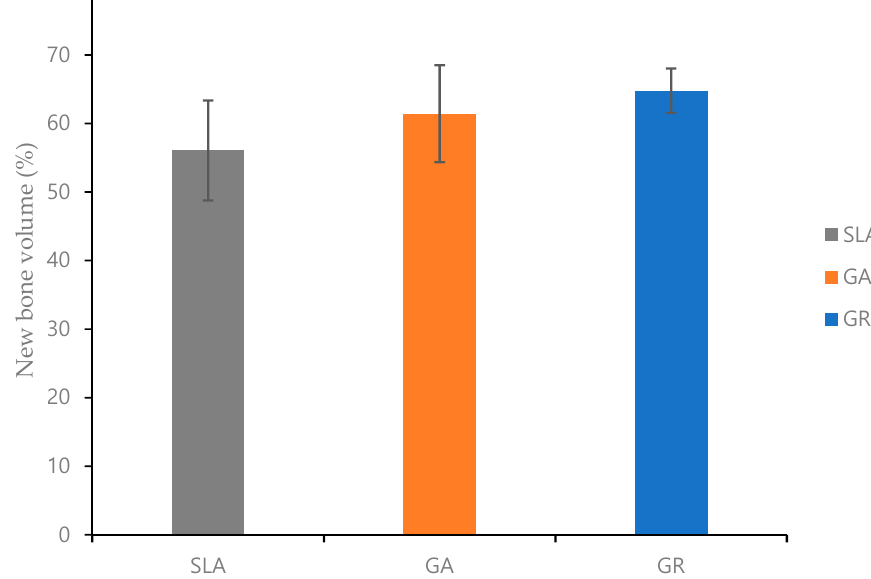
Figure 6. The volumetric ROI analysis of new bone.